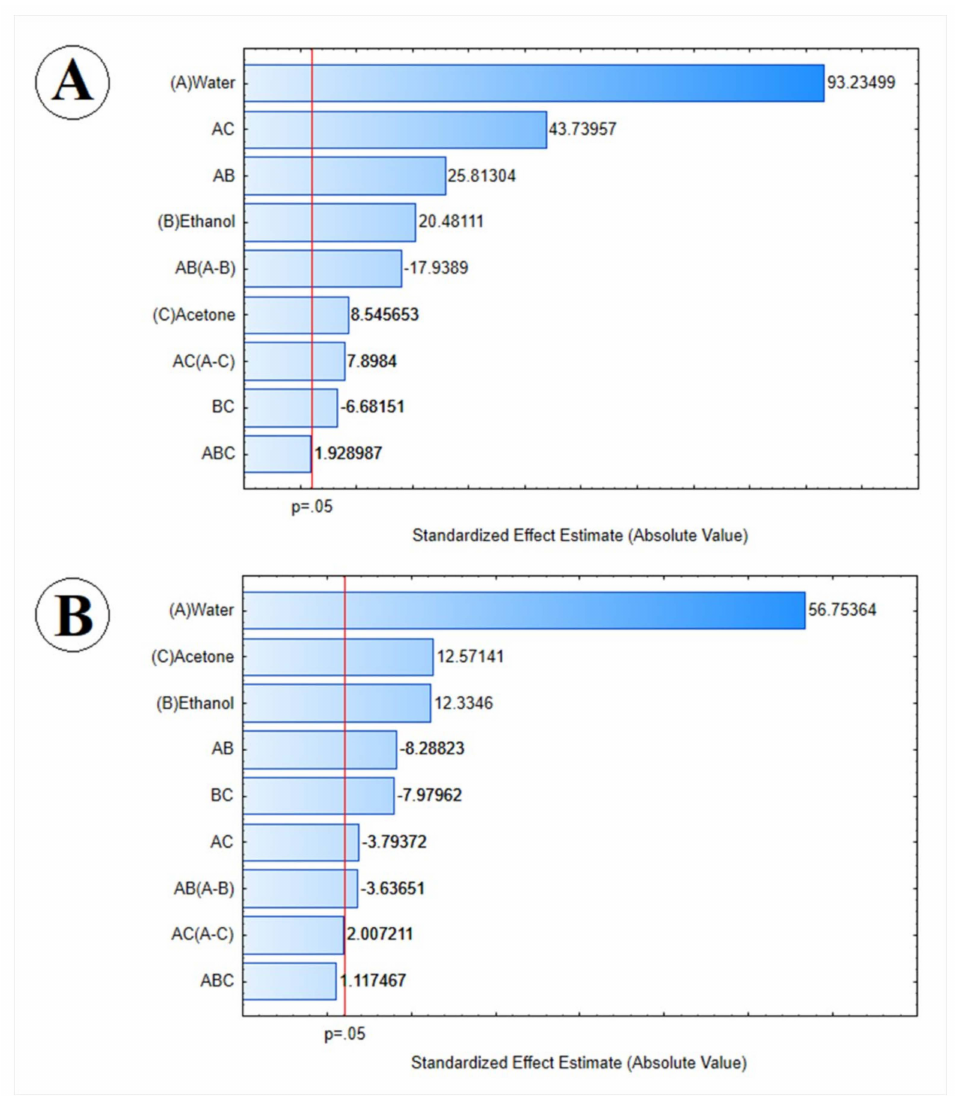
Figure 3. Standardized ( p < 0.05) Pareto chart representing the estimated effects of parameters and parameter interactions on ( A ) total phenolic compound and ( B ) thiosulfinate